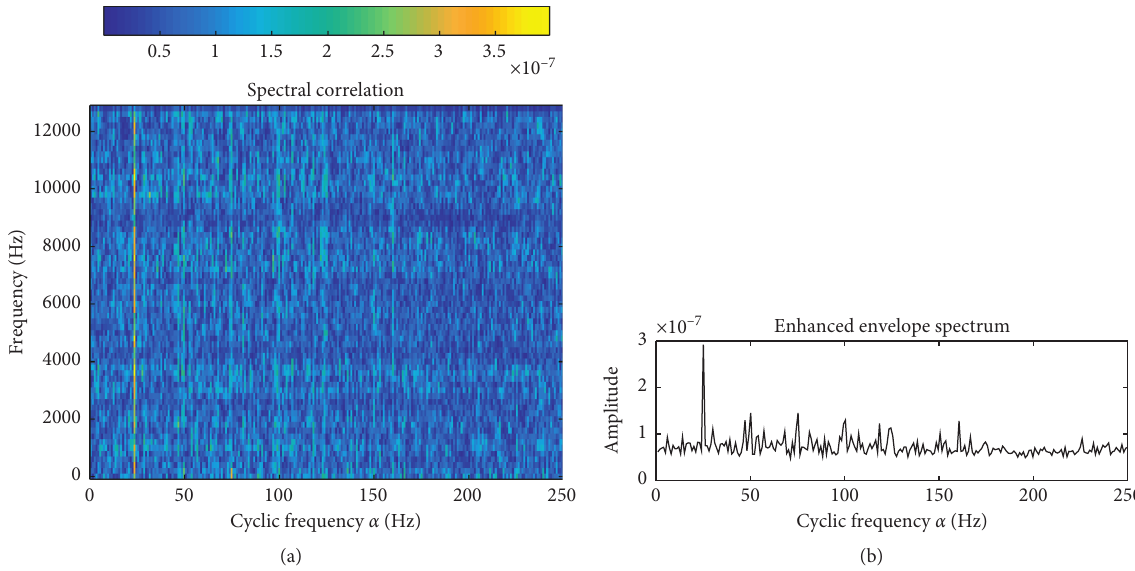
Figure 2: FSC image and EES of the signal as shown in Figure 1(b): (a) FSC image of the signal as shown in Figure 1(b); (b) EES of the signal as shown in Figure 1(b) by using the obtained FSC image as shown in Figure